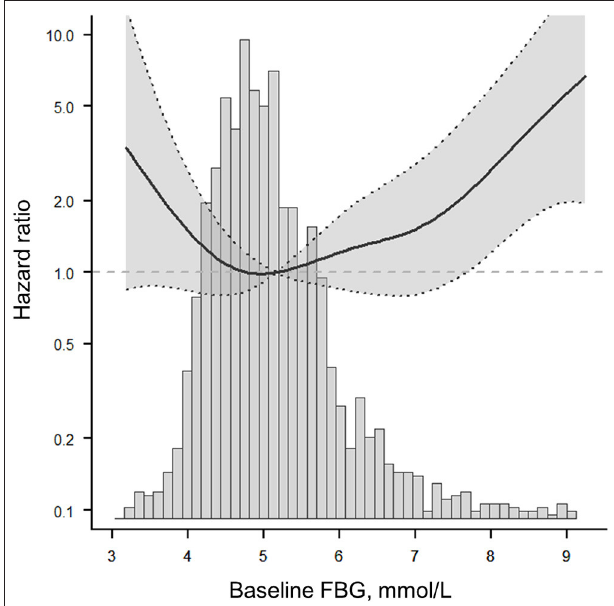
FIGURE 3 | The fitted curve shows a J-shaped relationship between baseline FBG and 1-year stroke recurrence in non-diabetic patients with ACI. The solid line indicates the adjusted hazard ratio and the dashed lines the 95% confidence interval